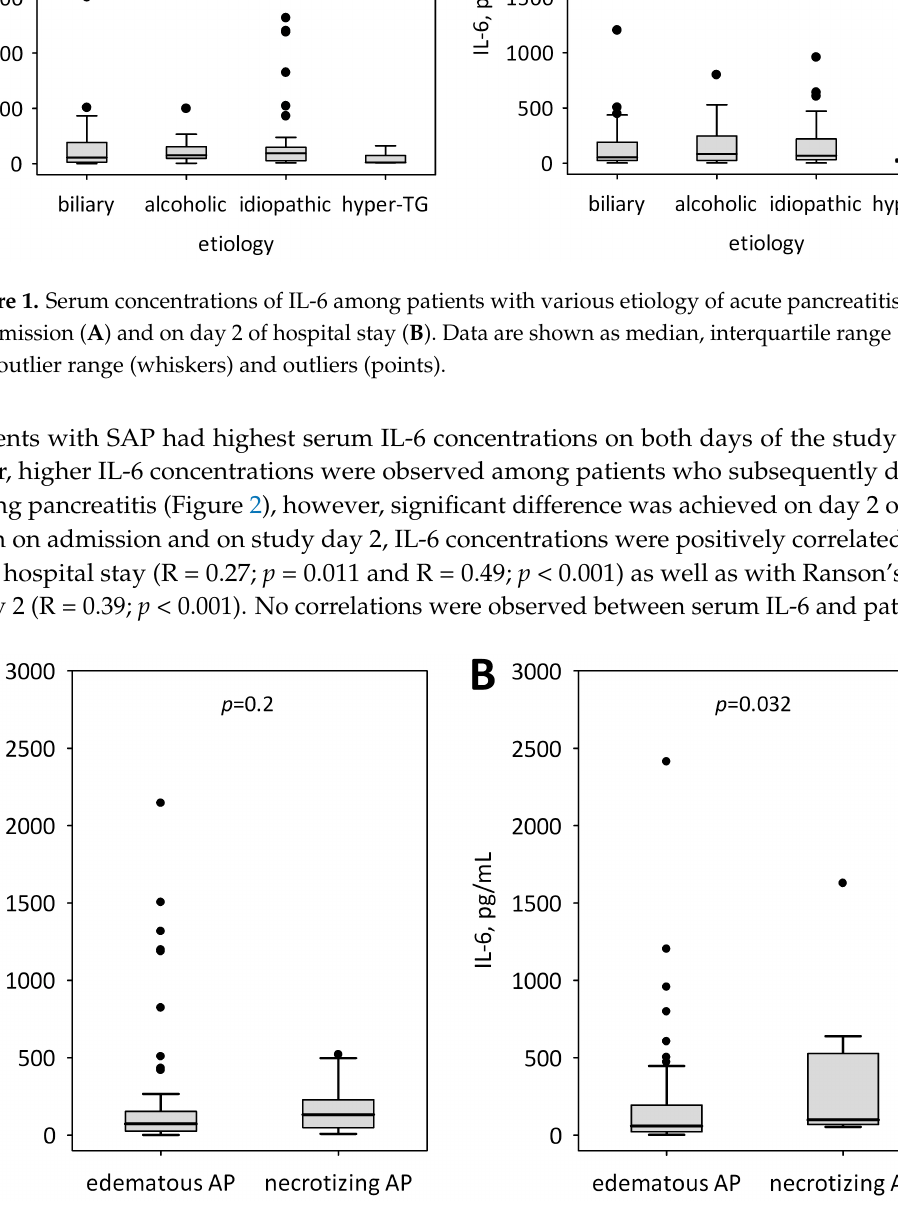
Figure 2. IL-6 concentrations at admission ( A ) and on day 2 of hospital stay ( B ) in edematous and necrotizing pancreatitis. Data are shown as median, interquartile range (box), non-outlier range (whiskers) and outliers (points).